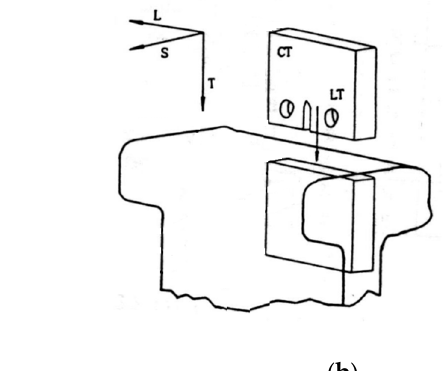
Figure 7. Specimen configuration for crack growth rate test.